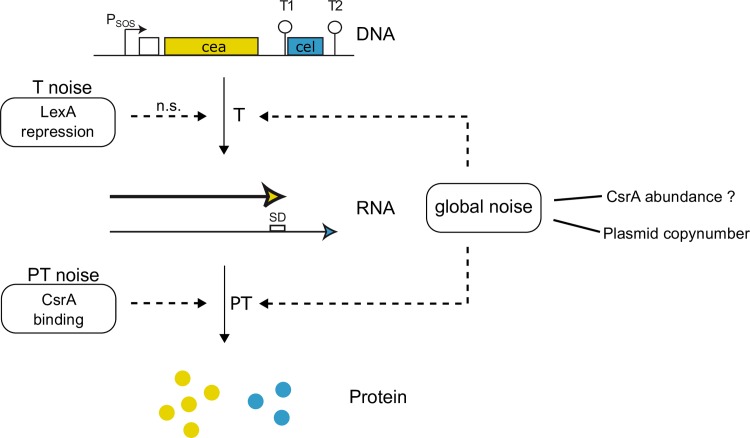
Factors contributing to noise generation in the ColicinE2-based regulatory network.T = transcriptional, PT = post-transcriptional. Solid arrows indicate regulatory mechanisms. Dashed arrows indicate noise influencing elements. n.s.: Variations of LexA binding did not lead to significant changes in population noise. ?: Question mark denotes that our data indicate that CsrA could act either direct or indirect as a global factor affecting population noise.